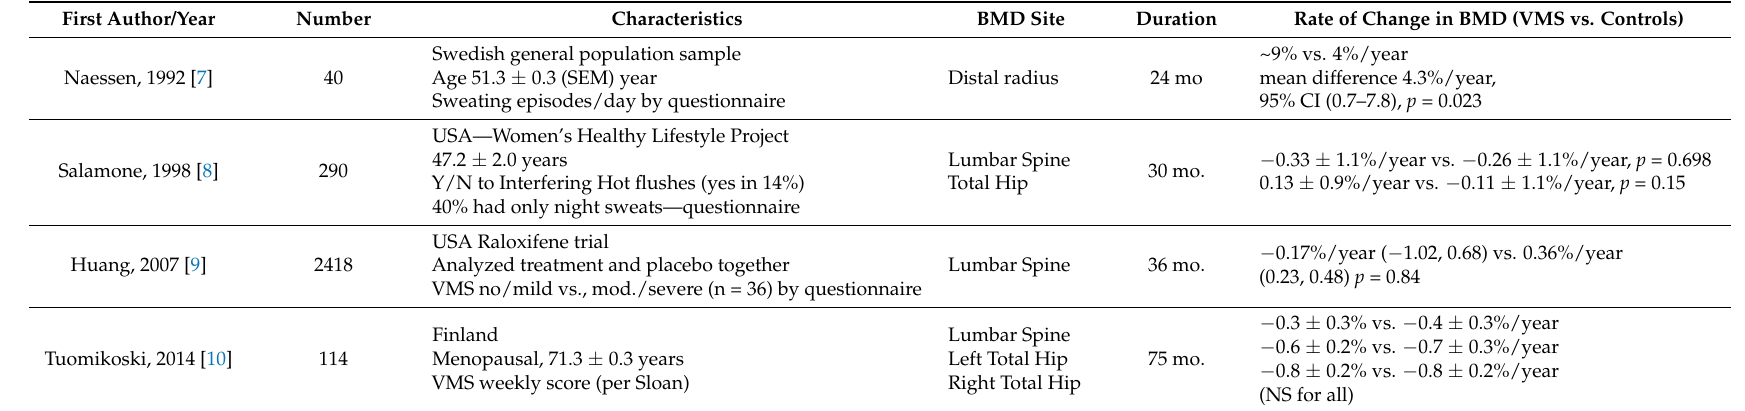
Table A1. Prospective Studies of Bone Mineral Density Change in Perimenopausal and Menopausal Women Related to Experiences of Vasomotor Symptoms that were moderate-severe or interfered with their